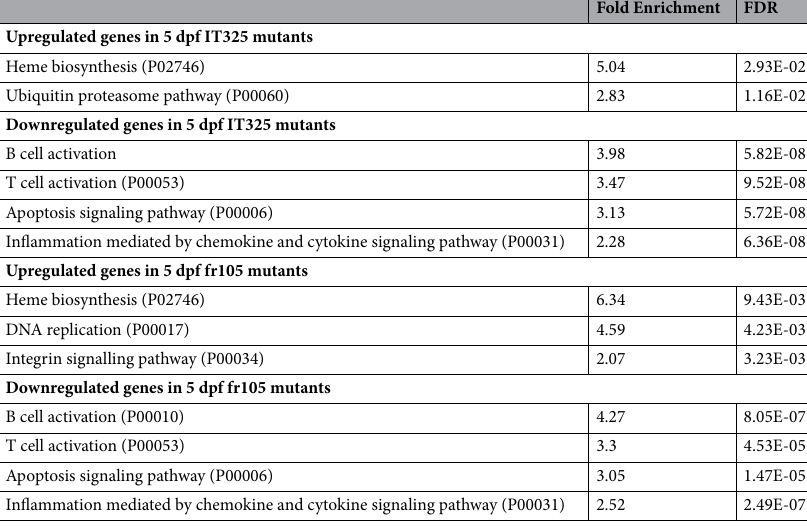
Table 1. Differentially regulated haematopoietic pathways in ikzf1